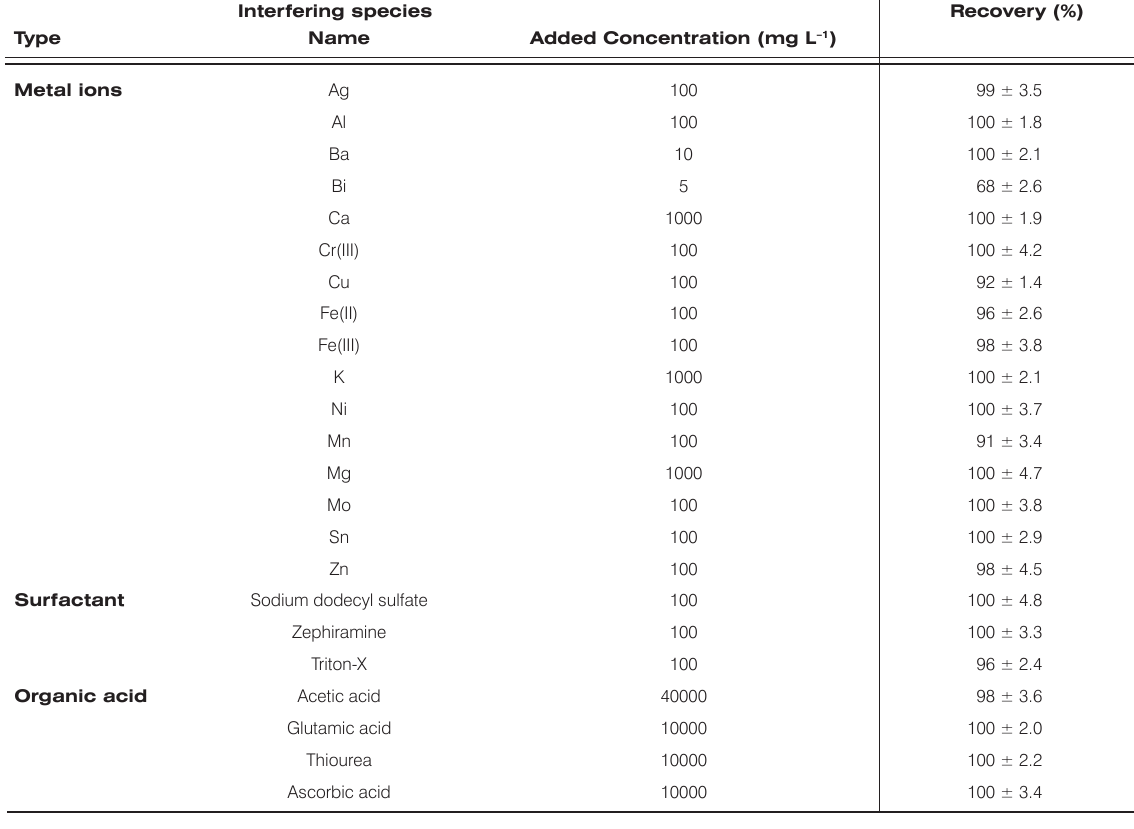
Table 1. Effect of interfering species.